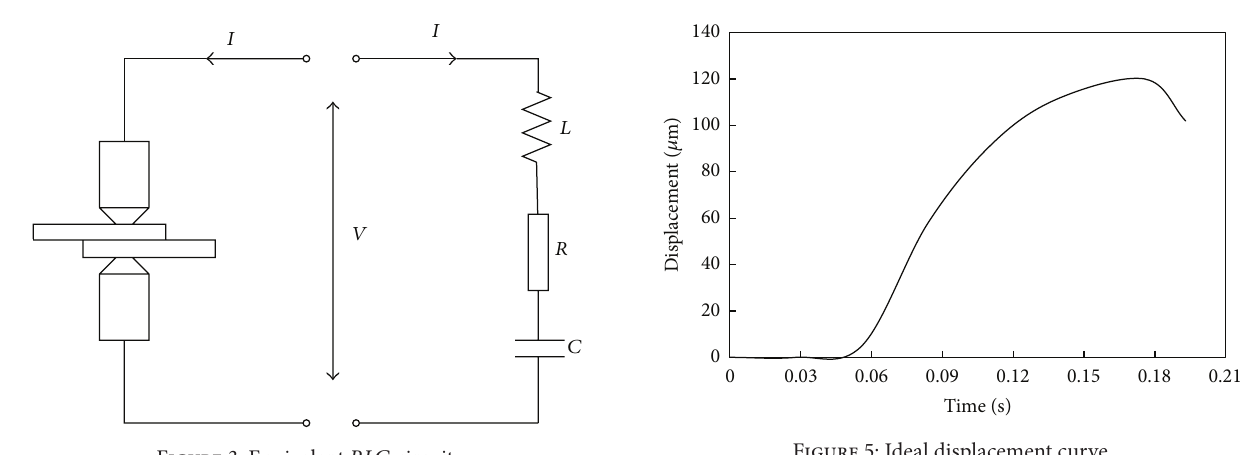
Figure 3: Equivalent 𝑅𝐿𝐶 circuit.